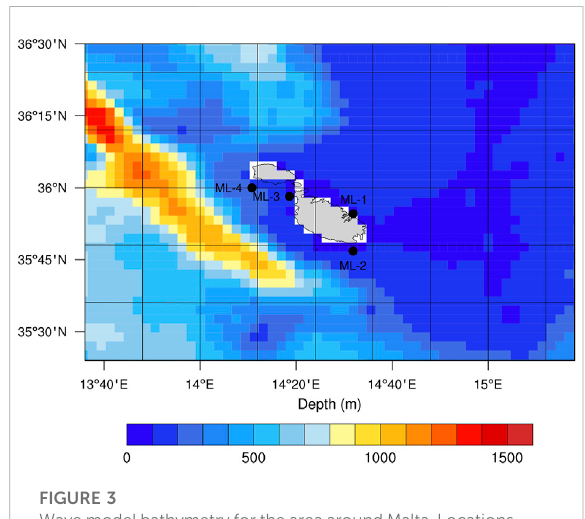
FIGURE 3 Wave model bathymetry for the area around Malta. Locations used for the speci fi c analysis are also